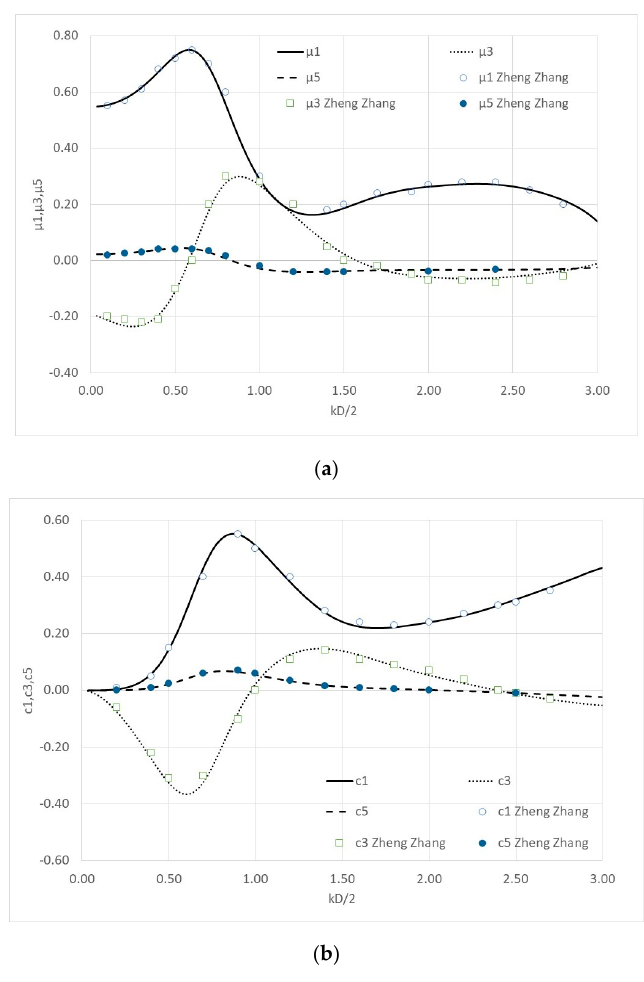
Figure 5. Dimensionless surge added mass ( a ) and surge damping coefficients ( b ) against k D/2 due to motions of the cylindrical body in surge, heave and pitch, for l w /D = 1. The results are compared with the analytical ones of [16].